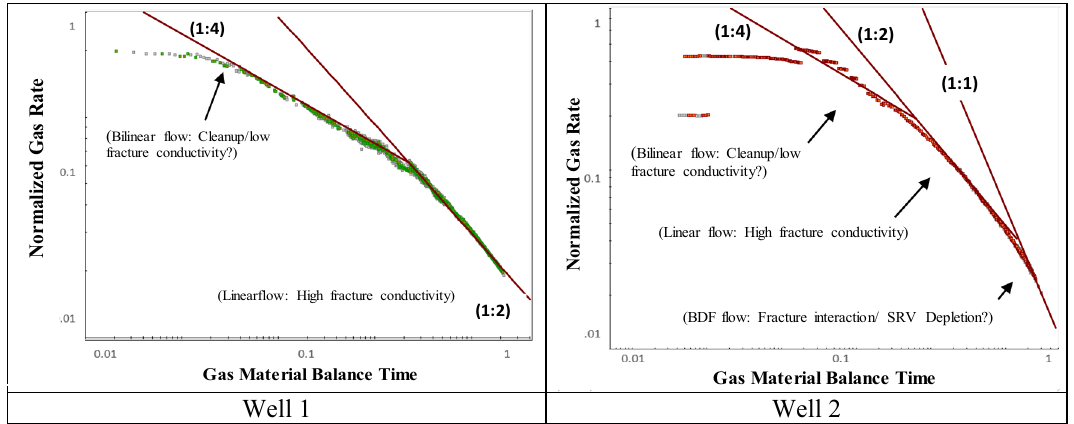
Fig. 3 Normalized gas production rate versus material balance time (log–log